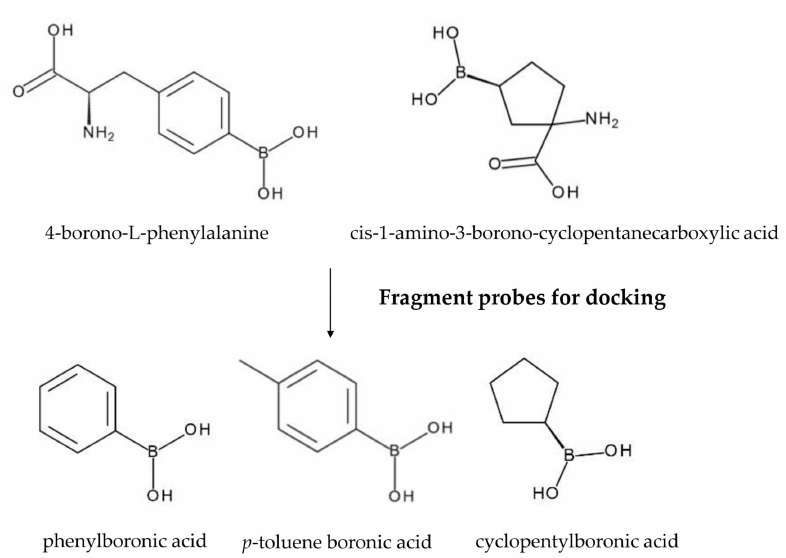
Figure 2. Chemical structures of the best boronated compounds identified and their fragments.